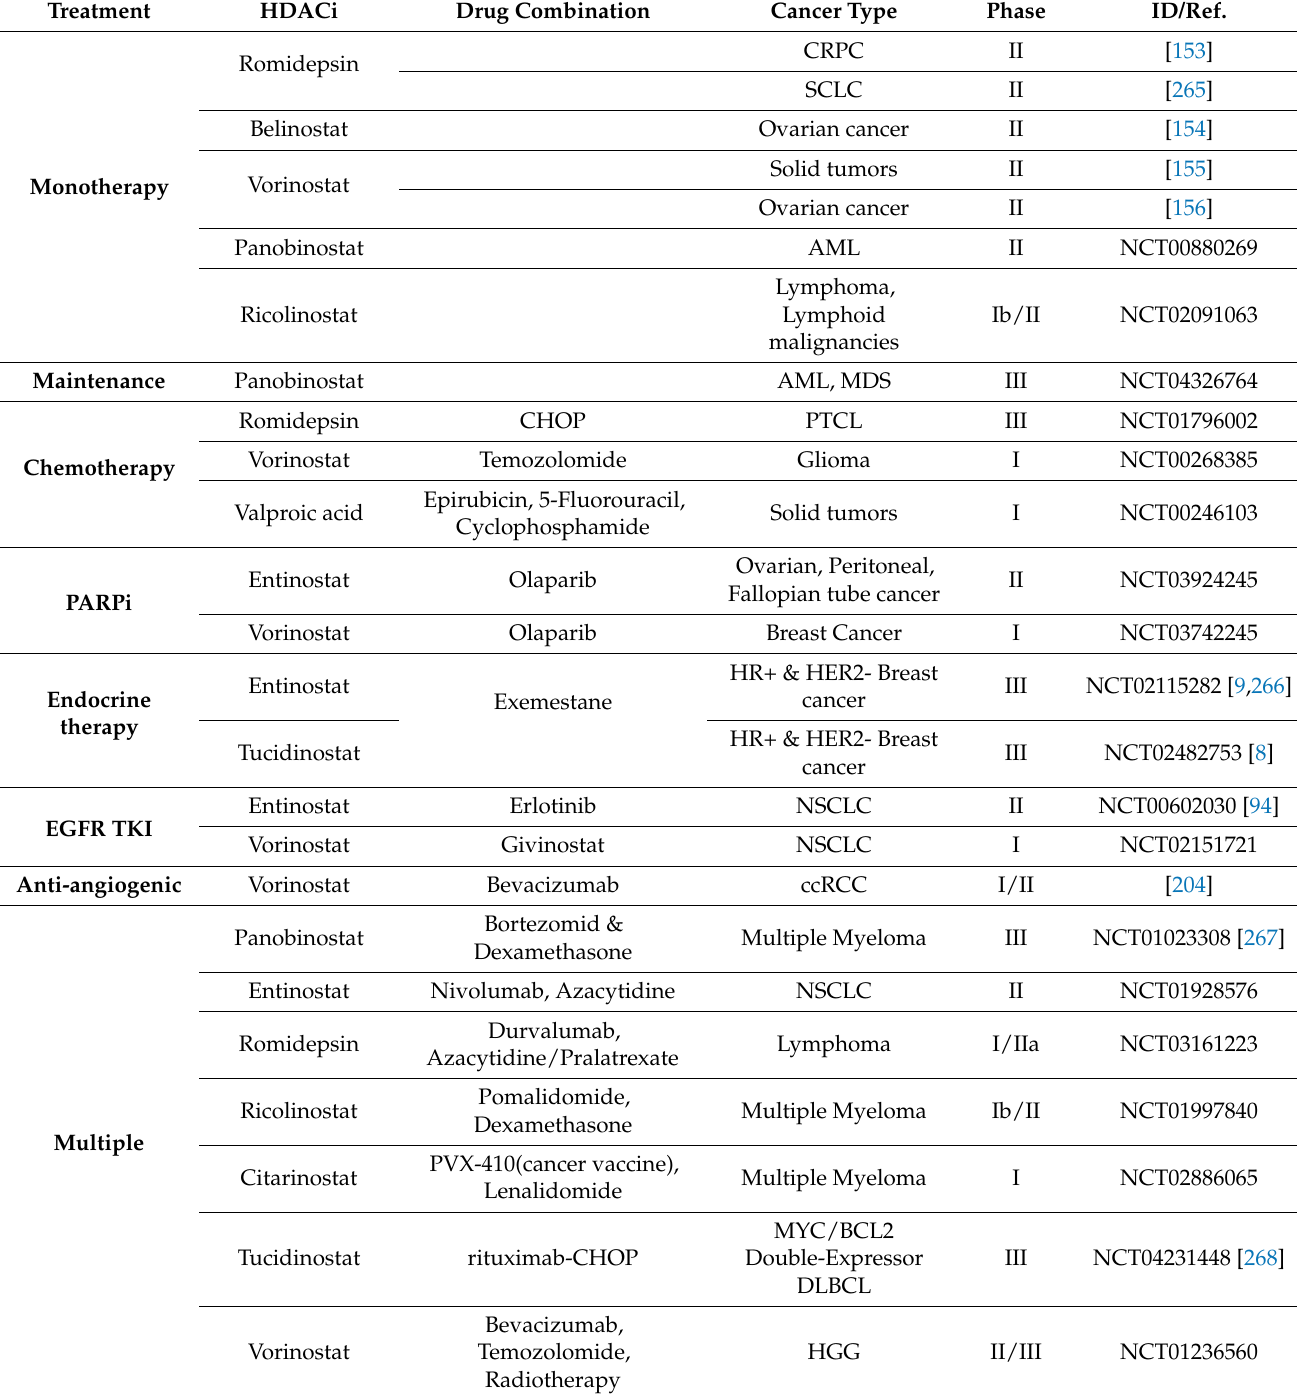
Table 3. Clinical trials evaluating HDAC inhibitors in cancer treatment. More clinical trials exploring drug combinations of HDACi can be found here [5–7]. Abbreviations: CHOP: cyclophosphamide, doxorubicin, vincristine, and prednisone; HR+: hormone receptor positive; HER2 − : human epidermal growth factor 2 negative; CRPC: castration resistant prostate cancer; SCLC: small cell lung cancer; AML: acute myelodysplastic leukemia; MDS: myelodysplastic syndrome; DLBCL: diffuse large B-cell lymphoma; HGG: high grade